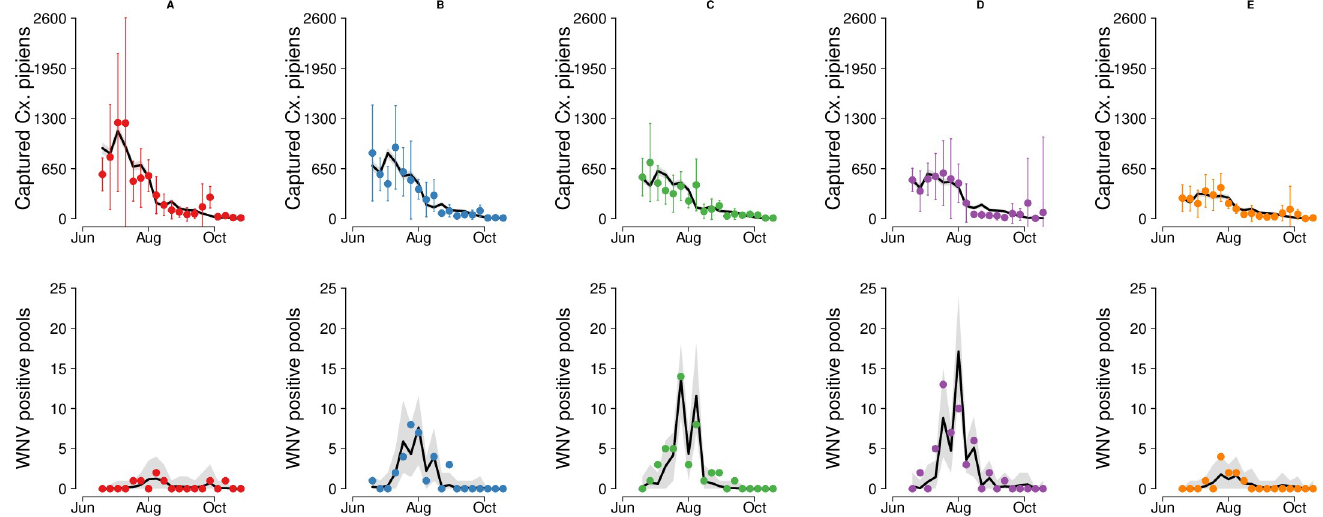
Fig 3. Models fit for 2018. Fit of the entomological (first row) and epidemiological (second row) models to the observed average number of captured Cx . pipiens mosquitoes and total number of WNV positive pools in 2018 by cluster (A: first column, B: second column, C: third column, D: fourth column, E: last column). Solid line: average. Shaded area: 95%CI of model predictions. Dots: observed data. Bars: 95%CI for the average of the observed captures.